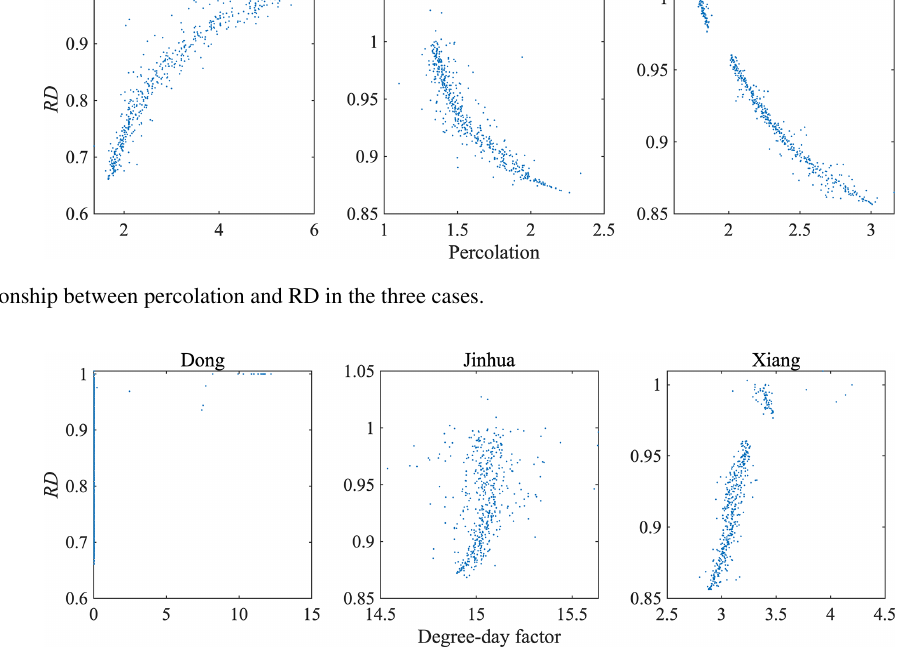
Figure 12. Relationship between degree-day factor and RD in the three